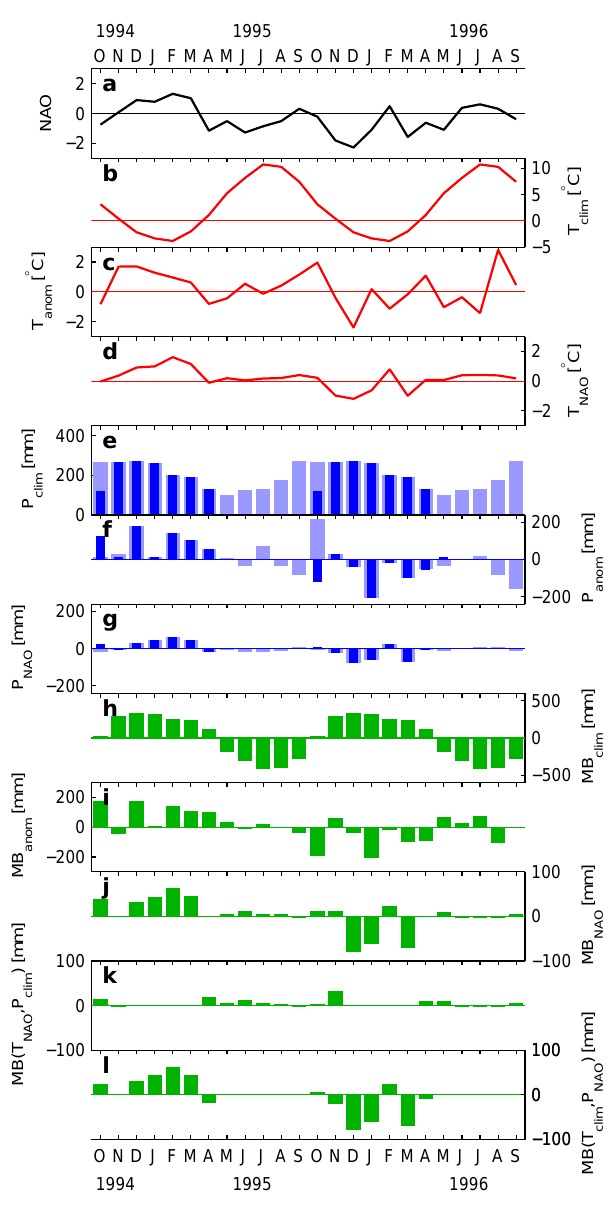
Fig. 7. Detailed example of the monthly time series of the re- construction for ˚Alfotbreen for the hydrological years 1995 and 1996. (a) NAO index. (b) Temperature climatology, T glacier . clim + T 0 (c) Temperature anomaly, T glacier . (d) Temperature glacier NAO anomaly associated with NAO, T glacier . (e) Precipitation clima- NAO + P 0 tology, P glacier . (f) Precipitation anomaly, P glacier . glacier clim NAO (g) Precipitation anomaly associated with NAO, P glacier . (In NAO panels e–g : light blue: total precipitation, dark blue: estimated solid precipitation) (h) Mass balance climatology, MB clim . (i) Mass balance anomaly, MB anom . (j) Mass balance anomaly associated with NAO variability in temperature and precipitation, MB NAO . (k) Mass balance anomaly associated with NAO temperature anomaly, MB (T NAO ,P clim ) . (l) Mass balance anomaly associated with NAO precipitation anomaly, MB (T clim ,P NAO ) . Equivalent figures are available for all 39 glaciers with more than 12 measured mass balance values as